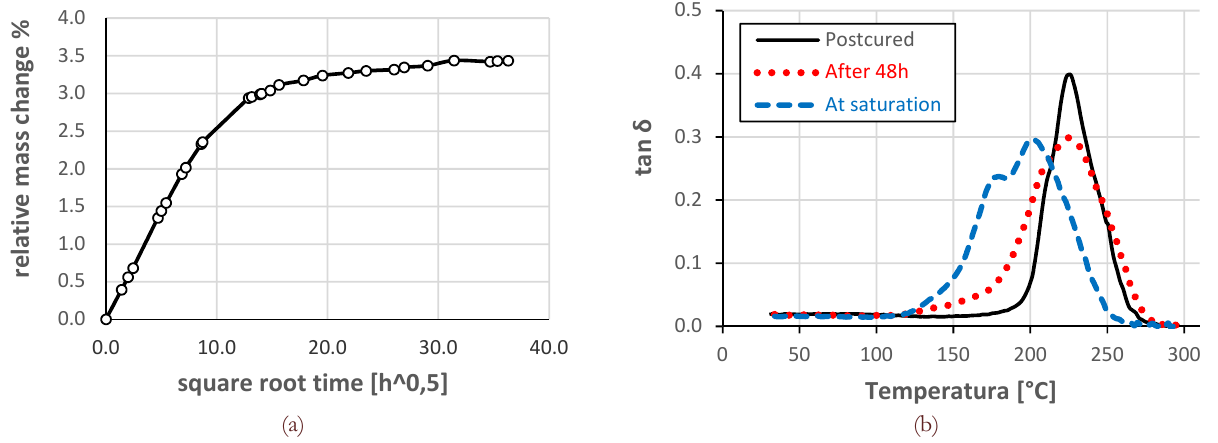
Figure 2: (a) Gravimetric analysis results; (b) DMTA tan  curves at various aging